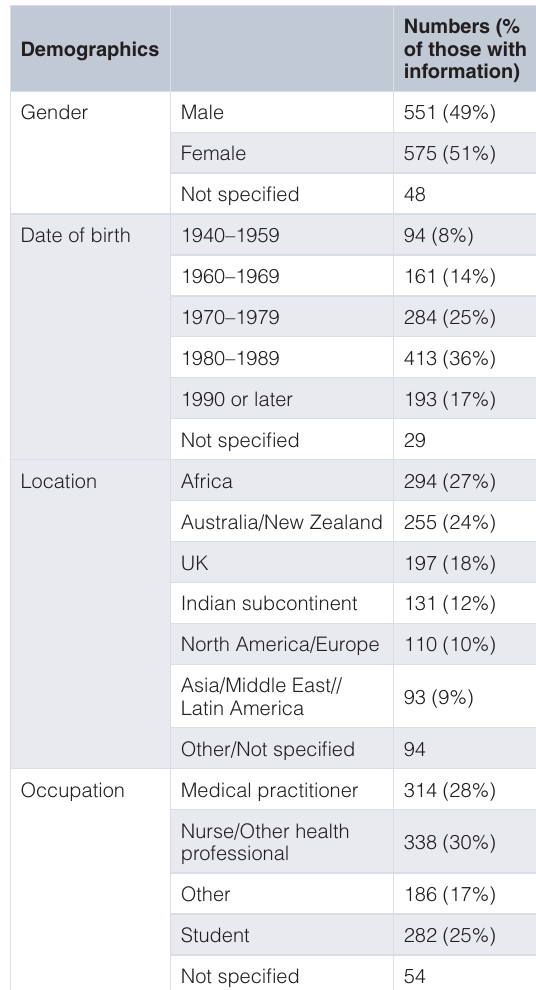
Table 2. Demographics of 1174 students registered in Peoples-uni Open Online